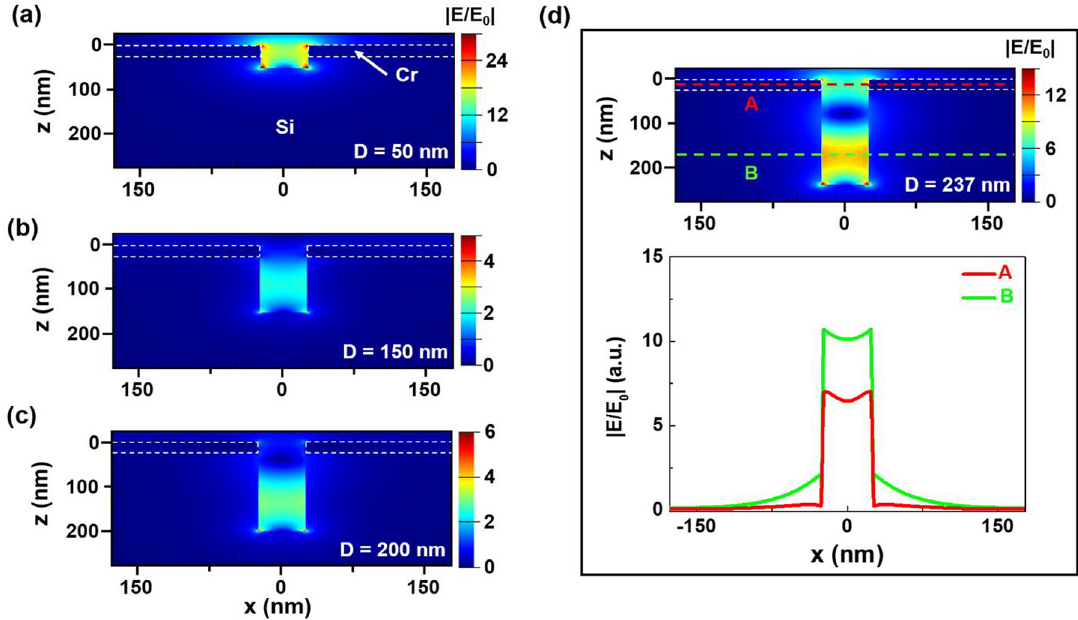
Figure 5: Simulations of the electric field distribution inside the columnar grooves with different depths under irradiation of femtosecond laser pulses. antinode positions marked by lines A and B in the upper panel of